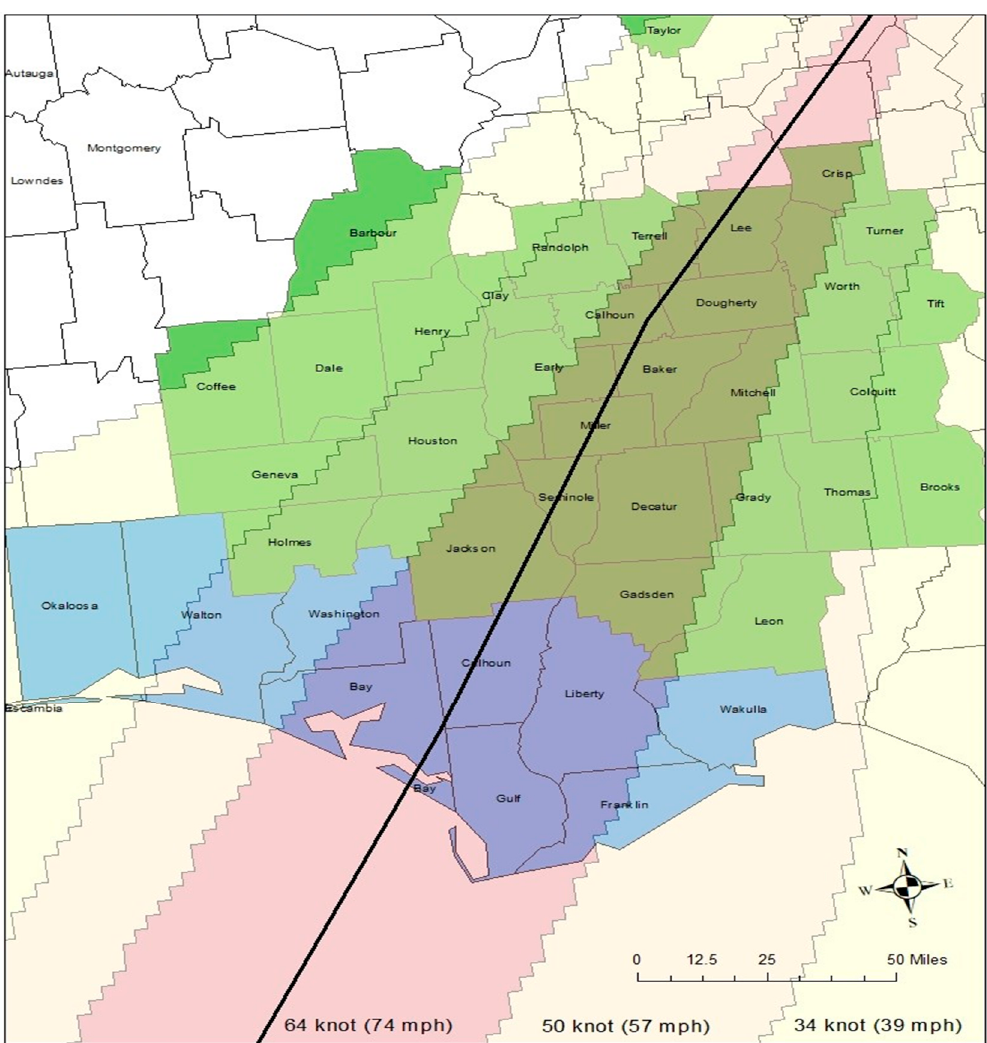
Figure 3. The track and wind swath of Hurricane Michael with Coastal counties (blue) and Inland counties (green).